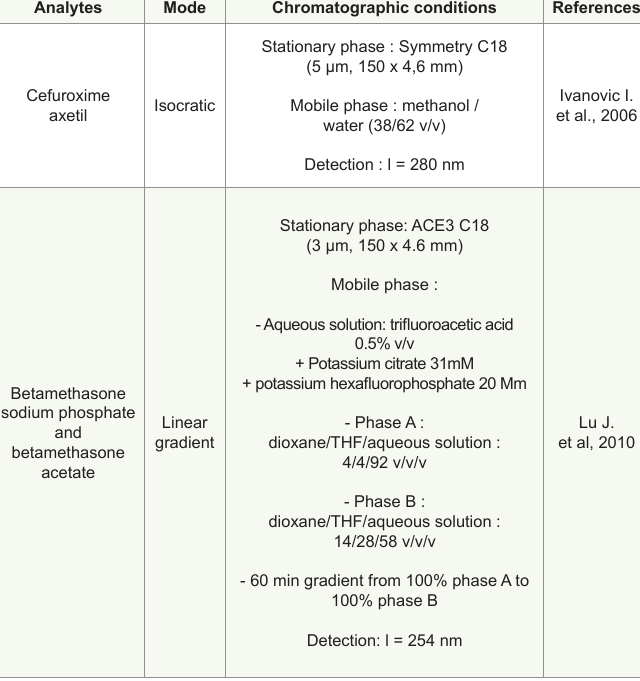
Table 3: Examples of reverse mode lC assay